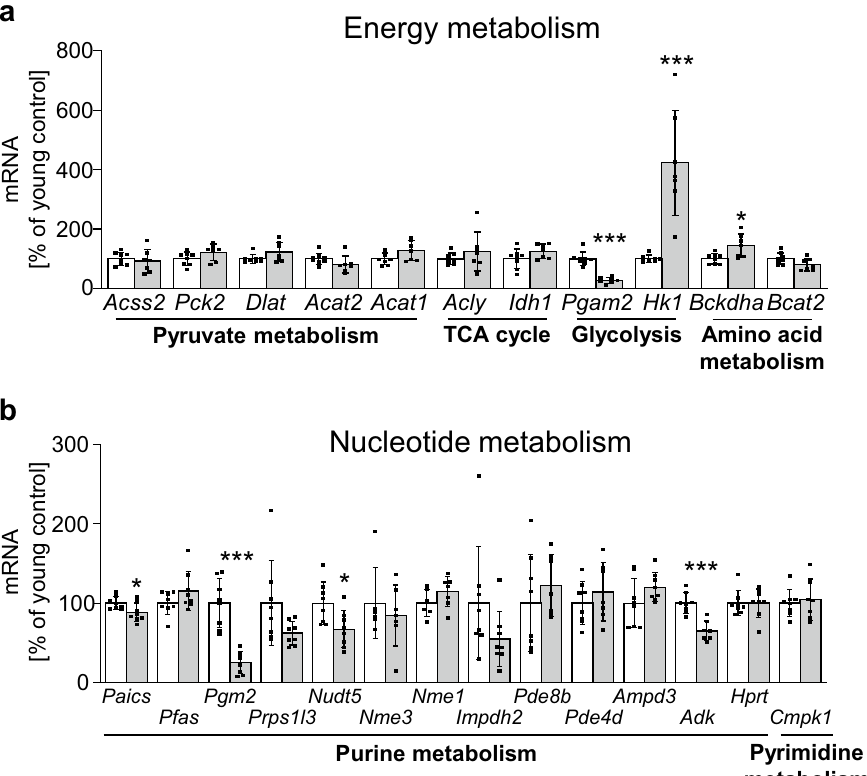
Figure 5. mRNA expression of biosynthesis and degradation genes linked to metabolites identified in aged BAT. ( a ) mRNA levels of nutrient/ energy metabolism genes (see Suppl. Table S5 for full gene names) comparing BAT samples of young (2.5 months; n = 8; white bars) and aged (15 months; n = 7; grey bars) mice. ( b ) mRNA levels of nucleotide metabolism genes comparing BAT samples of young (2.5 months; n = 8; white bars) and old (15 months; n = 8; grey bars) mice. All genes are organized according to pathway enrichment in the proteome analysis of the same age groups (Table 1). Data are expressed as percentage of young (2.5 months) control. Data are shown as mean ± SD; *p < 0.05; **p < 0.01; ***p < 0.001 using non-parametric Mann–Whitney